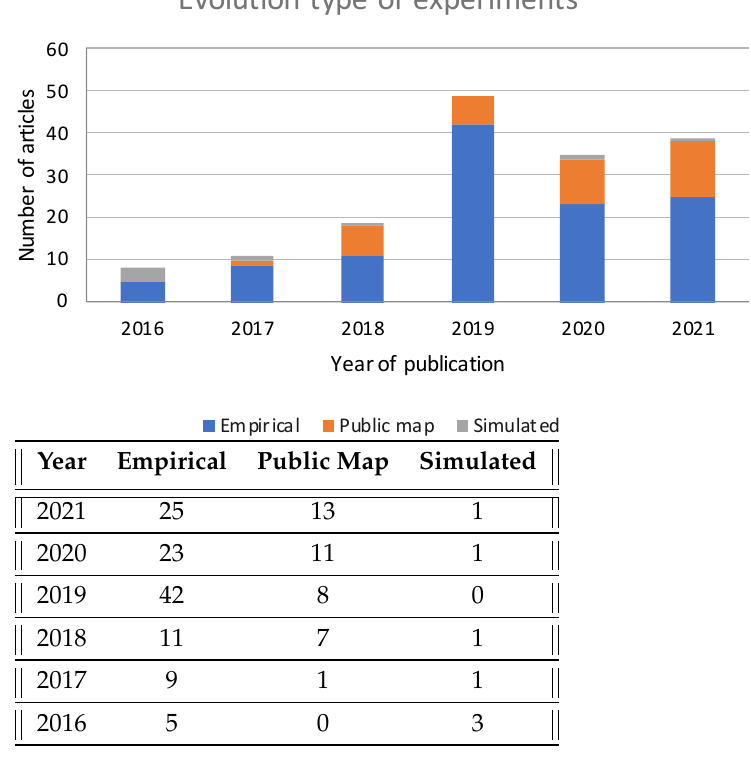
Figure 7. Evolution of experimental vs. simulated